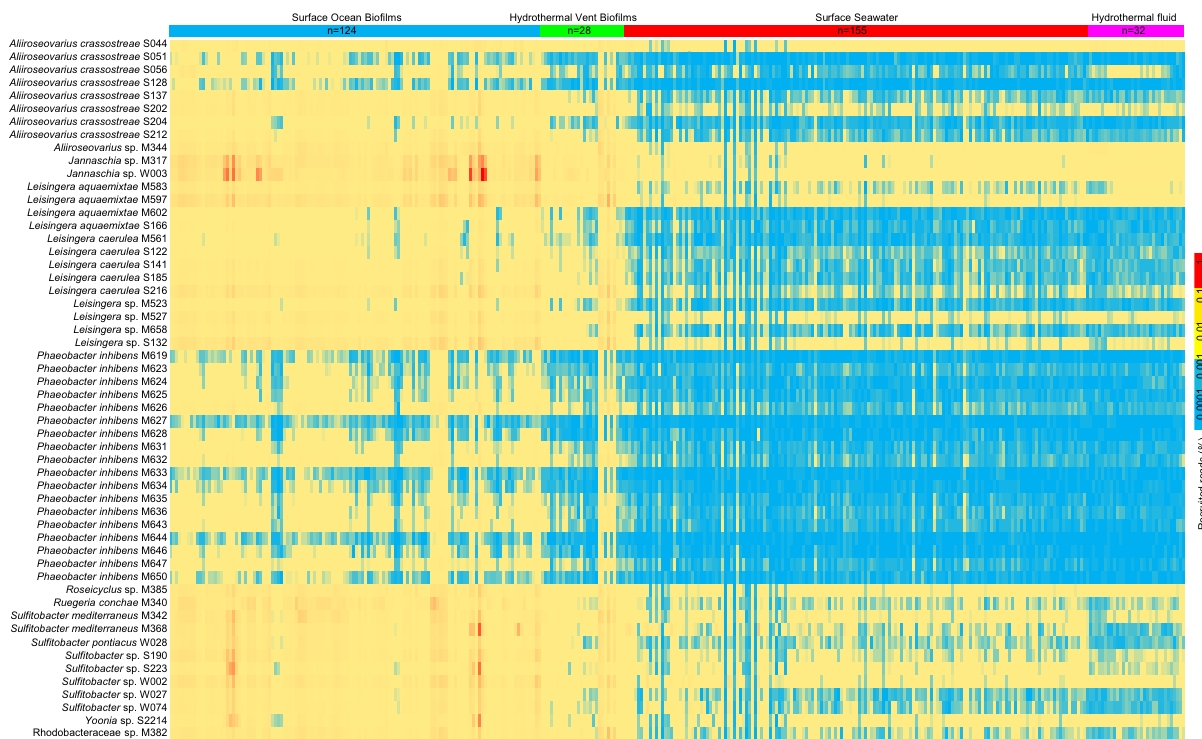
Fig.2|Globaldistributionof Roseobacter strainsinbio fi lm-associatedandfree- livingmicrobiota. Thedistributionpatternwasdrawnbymappingreadsfrom339 (152 bio fi lm and mat metagenomes versus 187 seawater and hydrothermal vent- fl uid metagenomes)to chromosomes of the 54bio fi lm-derived Roseobacter strains